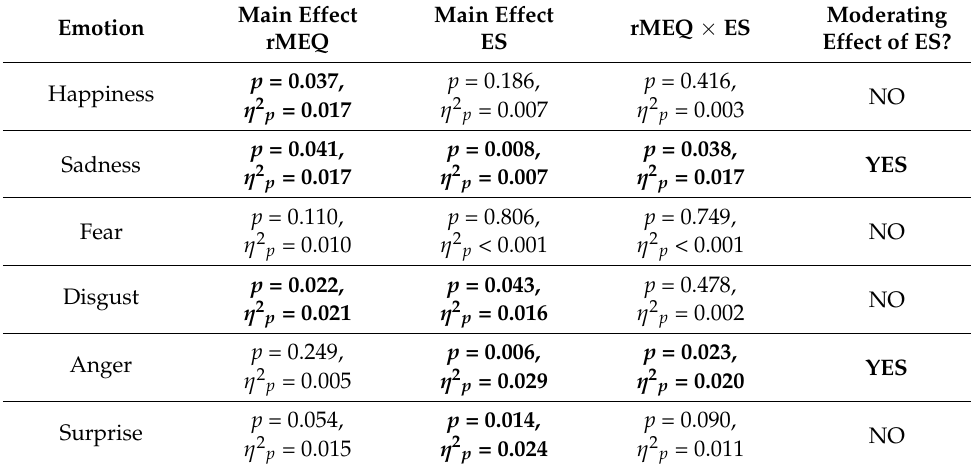
Table 1. Overview of models with expressive